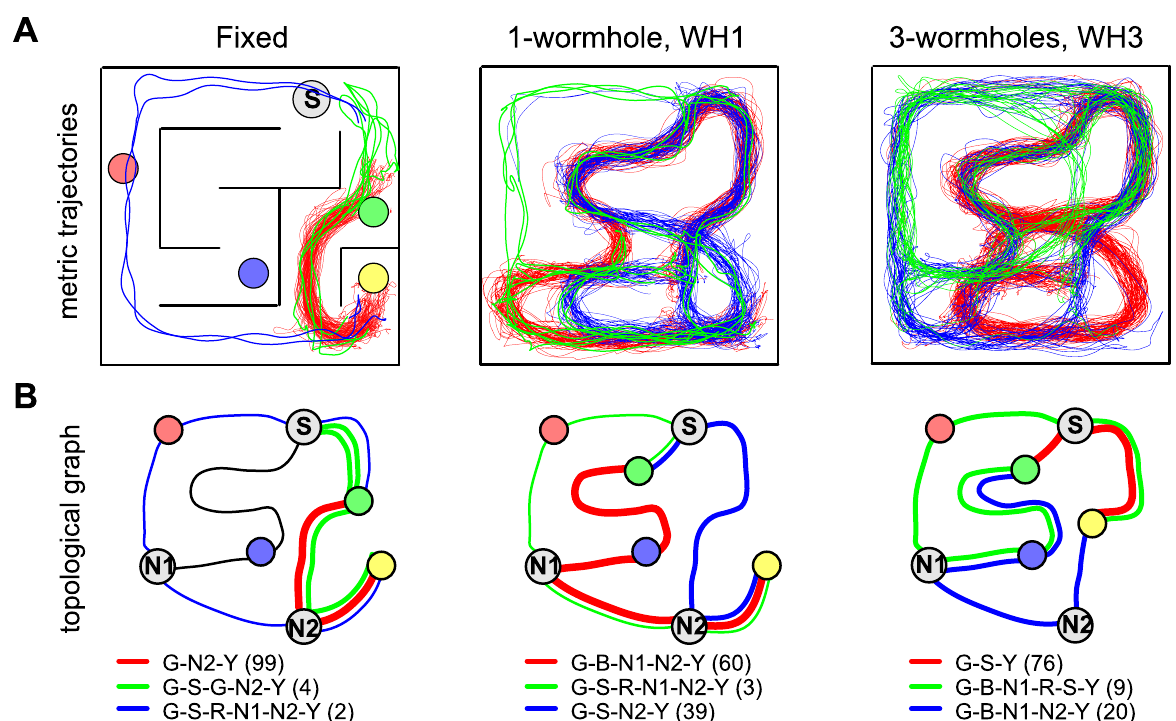
Fig 5. Examples of a participants’ paths. A) Trajectories of paths taken during one subset of the task, “go from G to Y” in Layout 1 for the Fixed, one-wormhole and three-wormhole conditions. The shortest path is marked in red, while green and blue lines represent alternative routes. Trajectories are drawn in the coordinate frame of the lab. B) Same data shown as a topological graph. Numbers in brackets indicate the number of times each route was taken (all participants, all runs). See Fig 2 for details of the layout in the wormhole conditions.